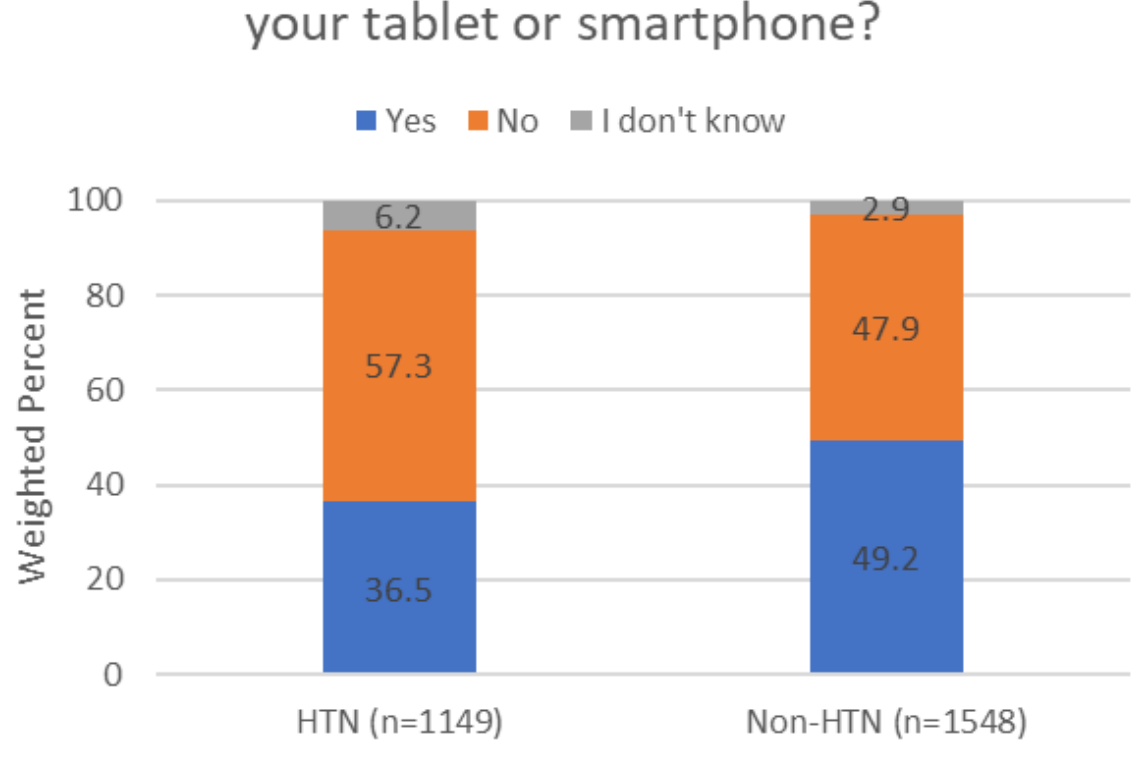
Figure 1. Use of health and wellness apps according to self-reported history of hypertension. Excludes those who answered “do not own a tablet or smartphone”. HTN: hypertension.